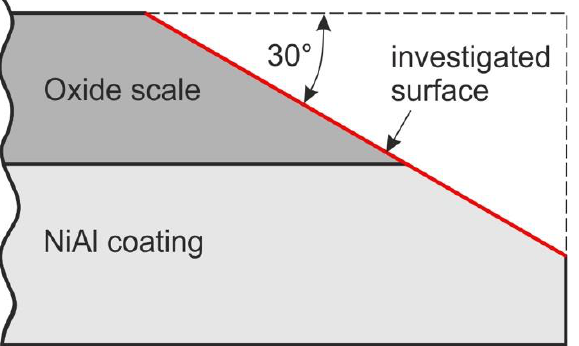
Figure 2. Scheme of ion beam cutting of oxide scale on an oxidized NiAl-based specimen.